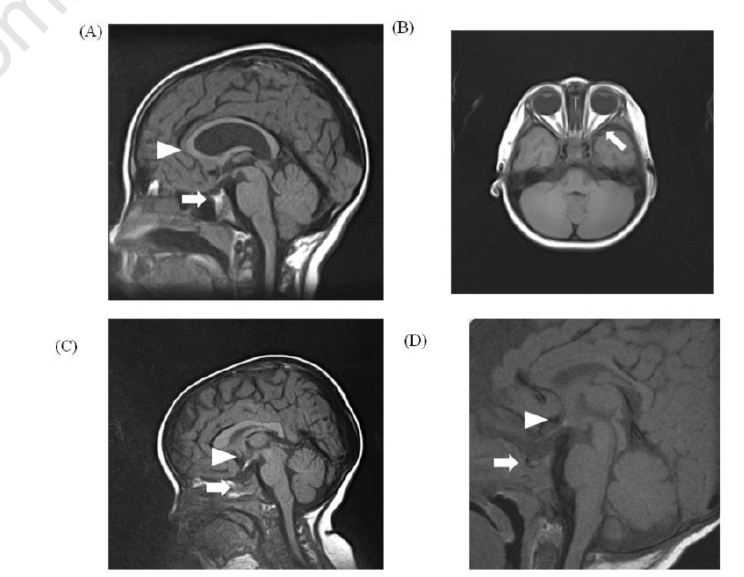
Figure 1. (A) A sagittal T1-weighted magnetic resonance image showing a small anterior pituitary (arrow) and the absence of the septum pellucidum (arrow head) in case 1. (B) com- puted tomography demonstrated right optic nerve hypoplasia (arrow) in case 2. (C) A sagit- tal T1-weighted magnetic resonance image showing a hypoplastic anterior pituitary and an ectopic posterior lobe in case 2. (D) A sagittal T1-weighted magnetic resonance image show- ing a hypoplastic anterior pituitary and an ectopic posterior lobe in case